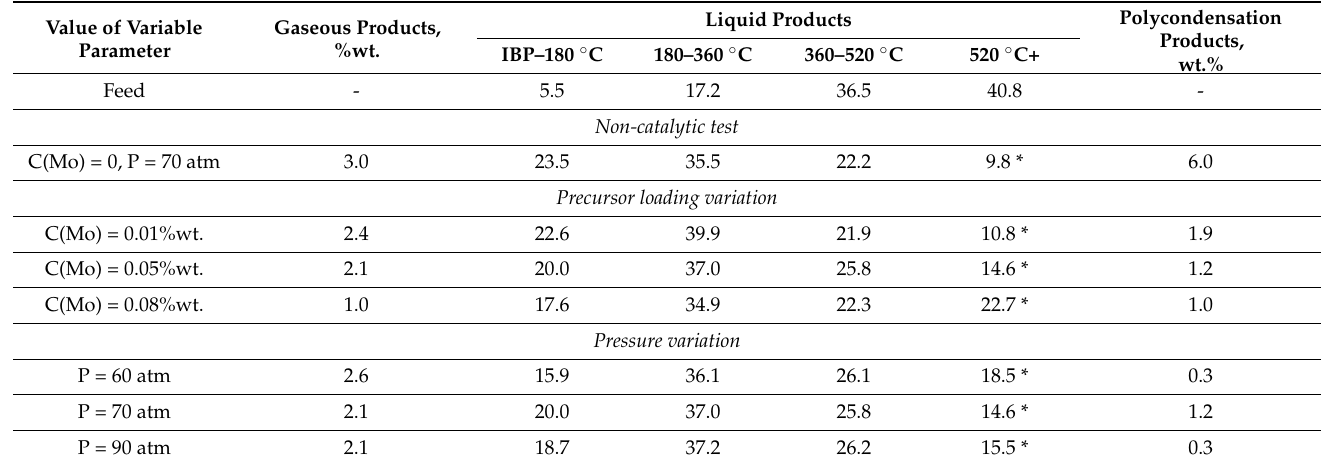
Table 2. Distribution of product in hydroconversion experiments.